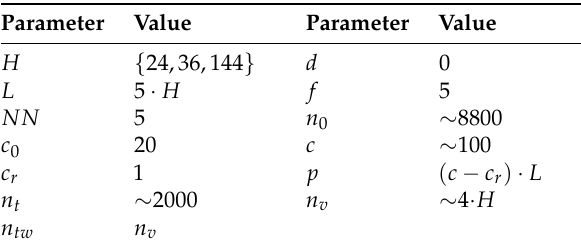
Table 3. Experimental setup: Case